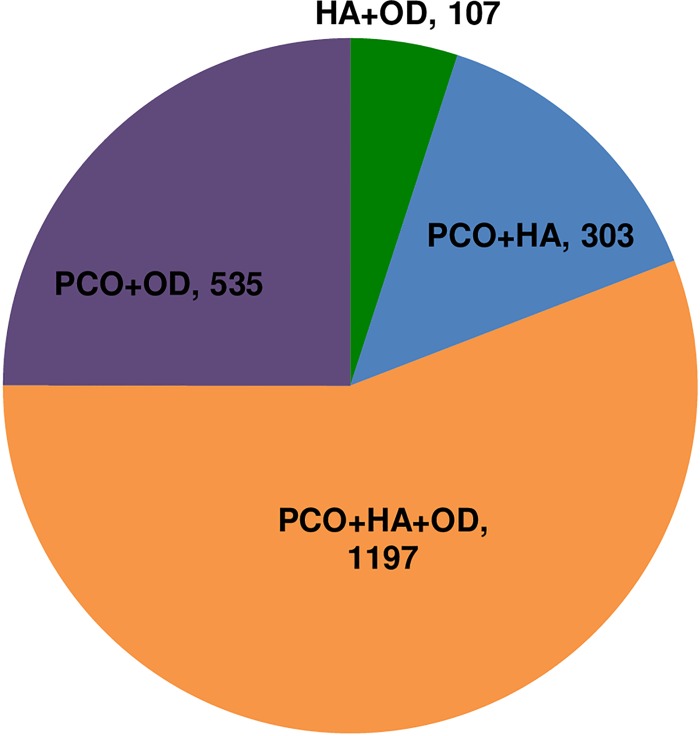
Distribution of PCOS Phenotypes in Female Participants (≥ 18 years of age).[PCO+HA+OD is the classic reproductive phenotype which has polycystic ovary morphology, androgen excess and ovulation dysfunction. PCO+HA is the ovulatory phenotype which has polycystic ovary morphology and androgen excess with ovulation. HA+OD is the phenotype which has androgen excess and ovulation dysfunction without polycystic ovary morphology. PCO+OD is the phenotype which has polycystic ovary morphology and ovulation dysfunction without androgen excess. Among 2436 young adults with PCOS (≥ 18 years of age), (1197/1981) were PCO+HA+OD, (303/2215) were PCO+HA, (107/2116) were HA+OD, and (535/1997) were PCO+OD.]